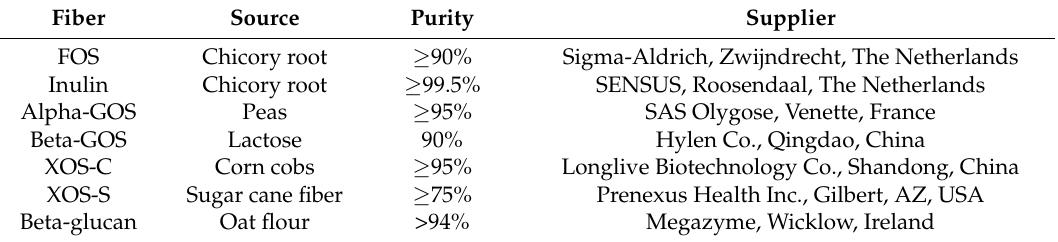
Table 1. Characteristics of fibers used in the in vitro